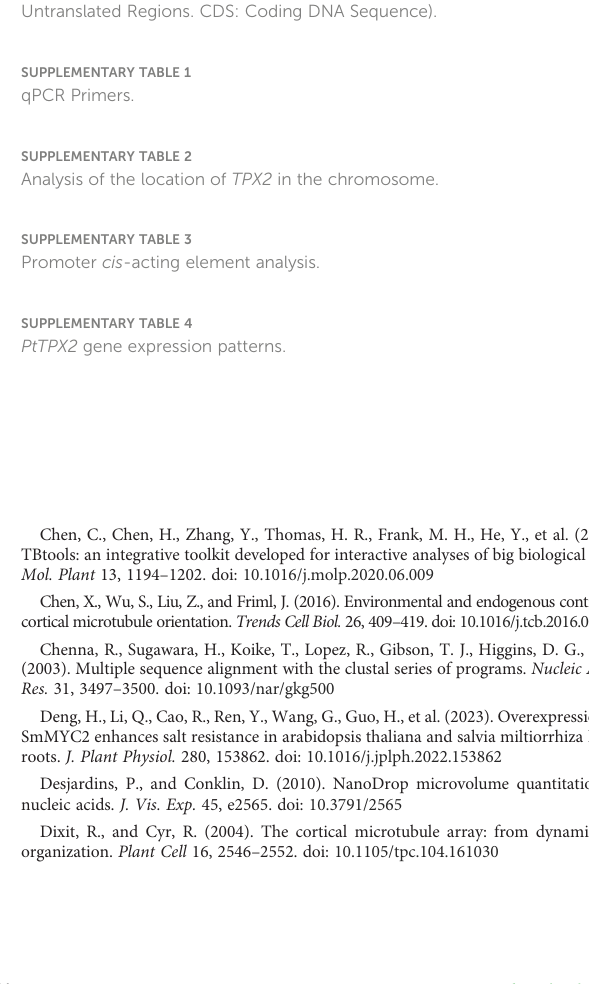
SUPPLEMENTARY TABLE 1 qPCR Primers.